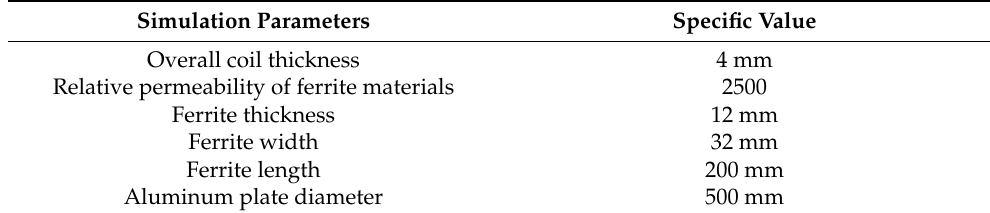
Table 2. Key parameters of the circular transformer